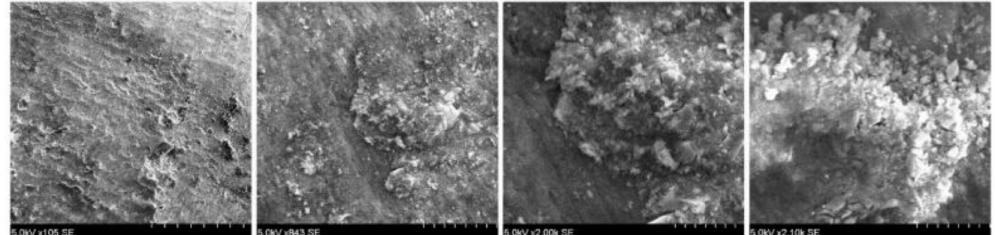
Figure 4. Microscopic appearance of enamel after removal of metal brackets 6.0 kV.